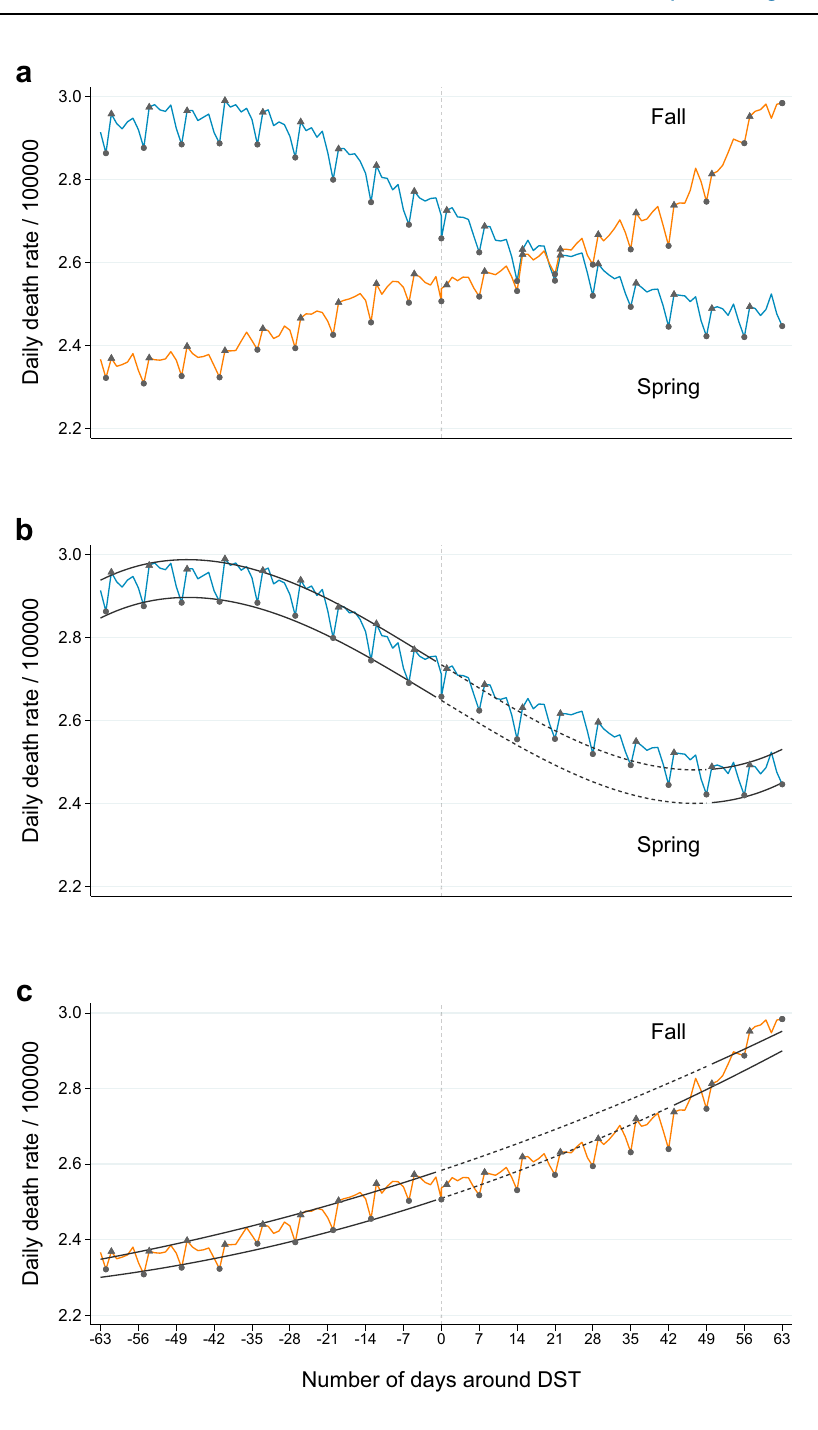
Fig. 1 | Unadjusted average daily death rate/100,000 observed in 16 European countries (1998 – 2012). Vertical dotted line: DST transition date. Blue curve: spring.Orangecurve:fall.Greydots:Sundays.Triangles:Mondays. a Springandfall transition. b Spring transition with 3rd-degree polynomial regression envelop for